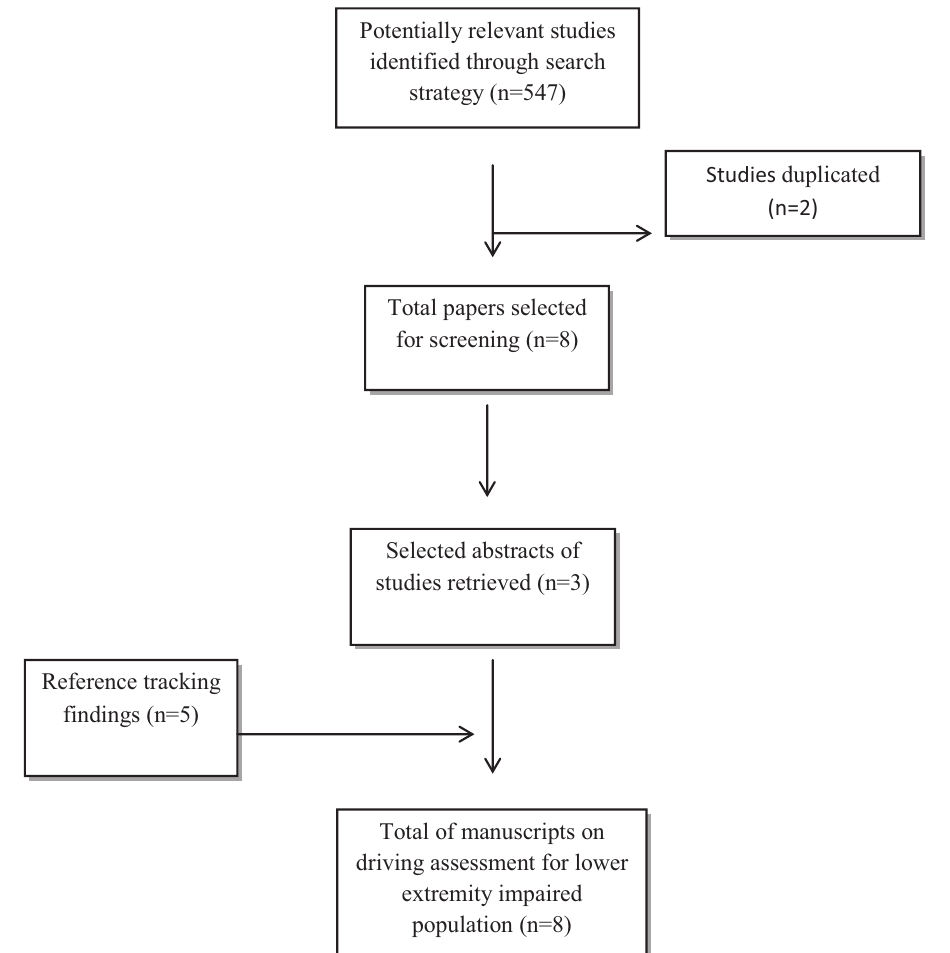
Figure 3 - Flowchart displaying detailed screening process and results of the search for driving assessment modalities for lower extremity impaired